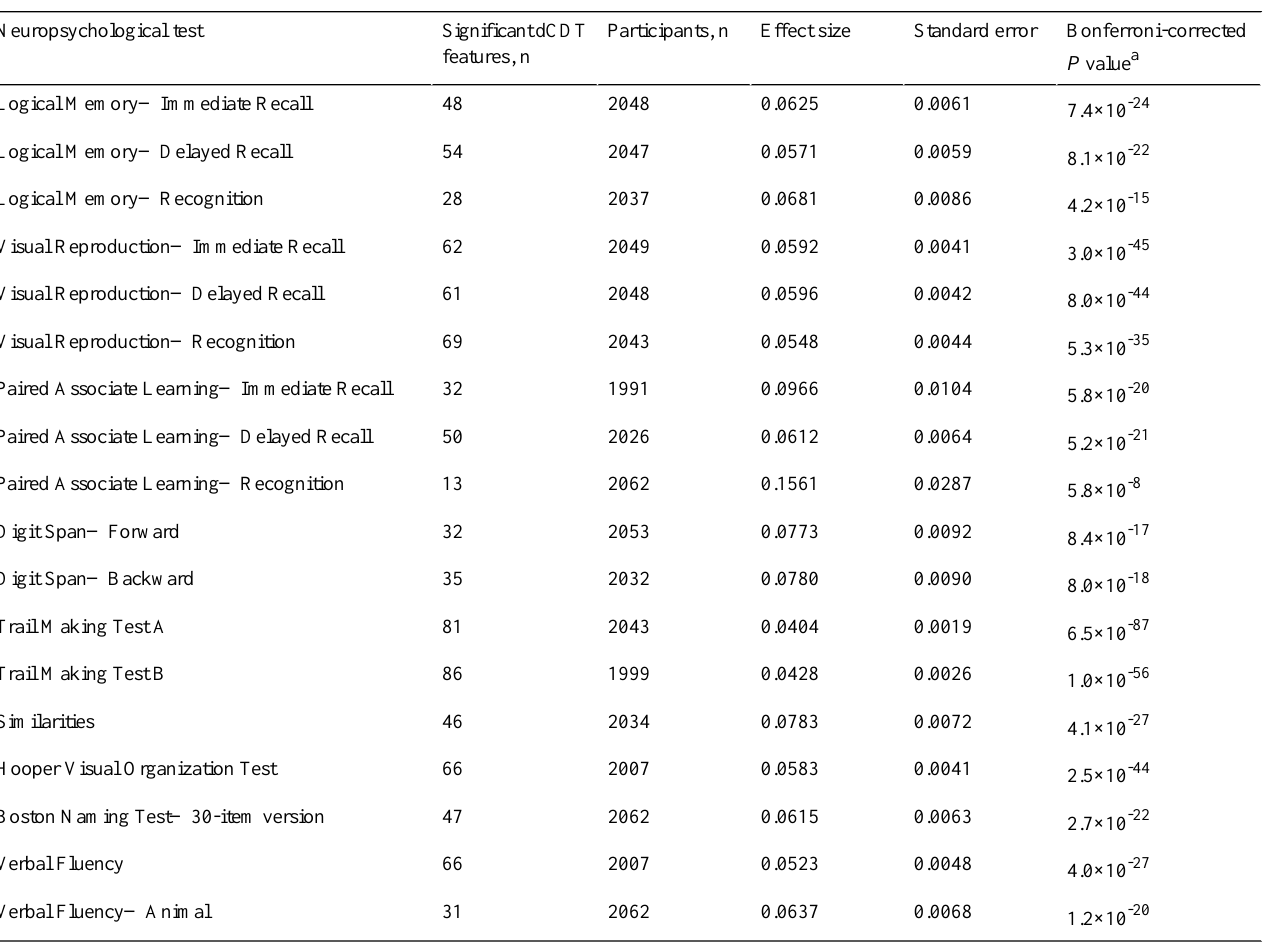
Table 2. Association between digital Clock Drawing Test (dCDT) composite scores and neuropsychological